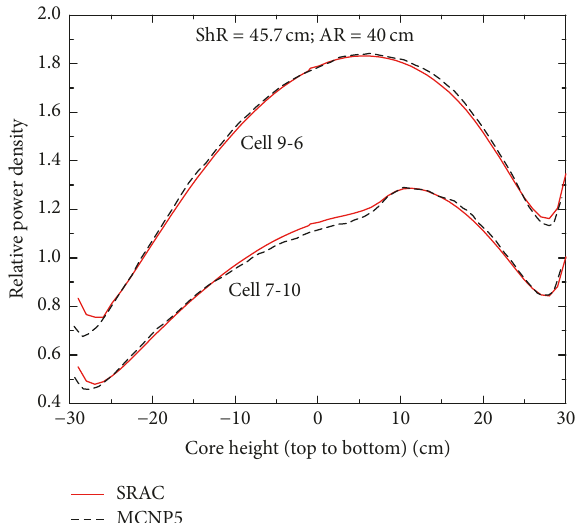
Figure 8: Axial power distribution along the fuel bundles 7-10 and 9-6 at the critical core condition corresponding to the insertion of control rods ShR = 45.7 cm and AR = 40